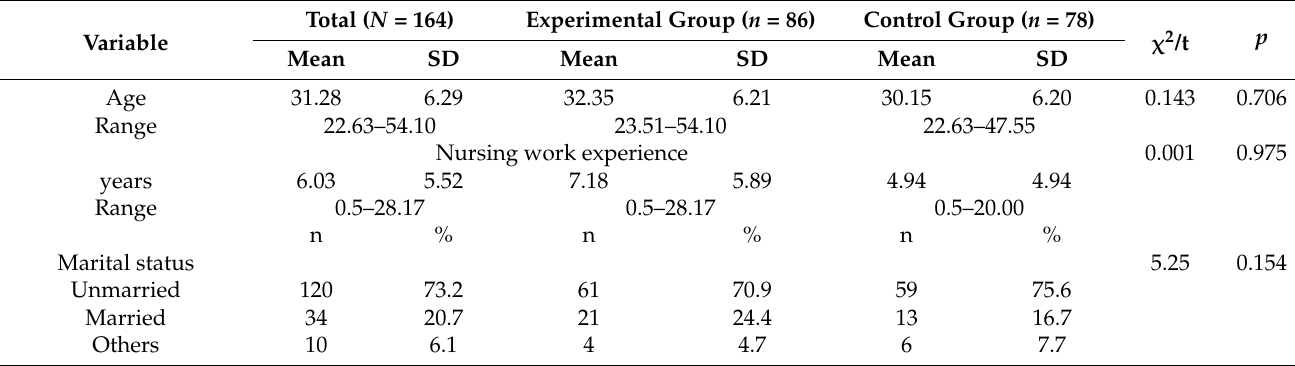
Table 1. Demographics of the study population (N = 164).